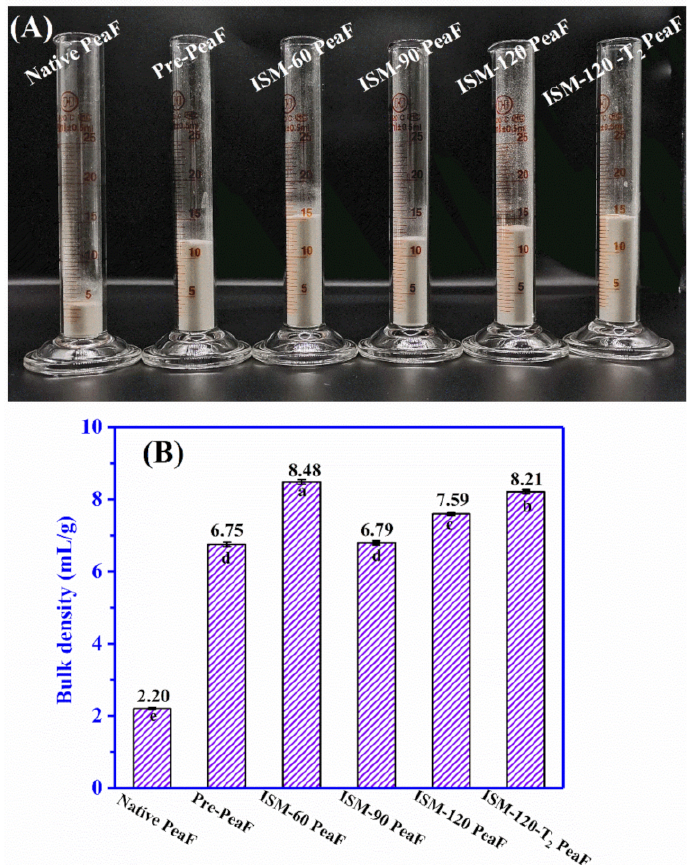
Figure 4. The graph of appearance volume ( A ) and bulk density ( B ) of ISMS-treated PeaF. Different letters in ( B ) indicated significant differences ( p < 0.05) of bulk density between